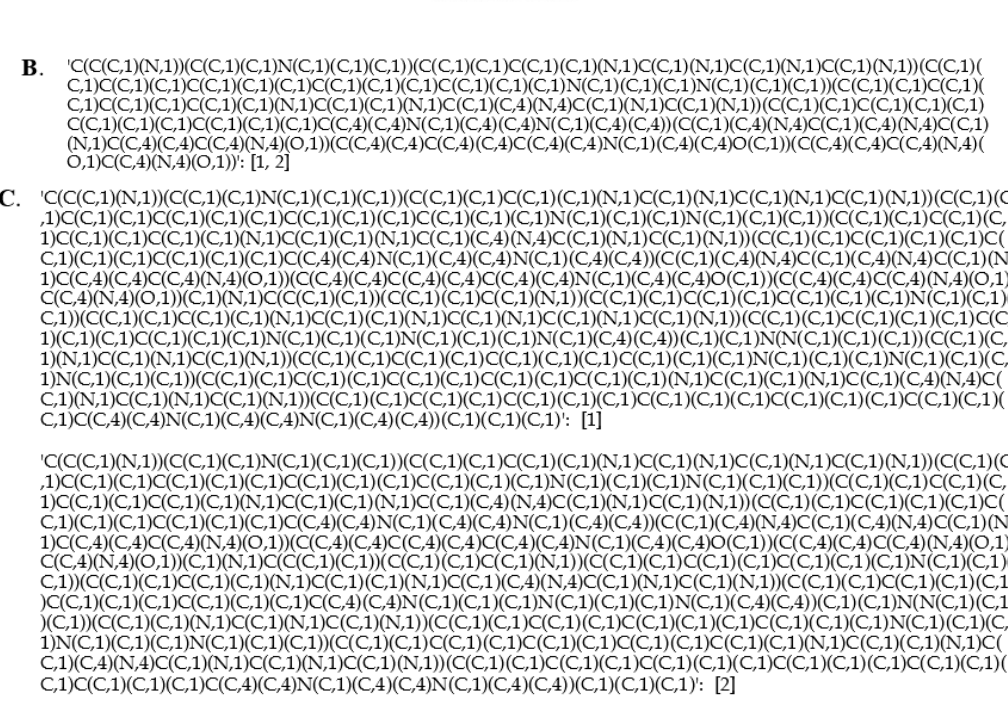
Figure 3. ( A ) Example of compound with same atom identifier for asymmetric atoms using an overly simplistic coloring approach; ( B ) the atom identifiers for atom 1 and 2 before symmetry validation; ( C ) the atom identifiers for atom 1 and 2 after symmetry curation.